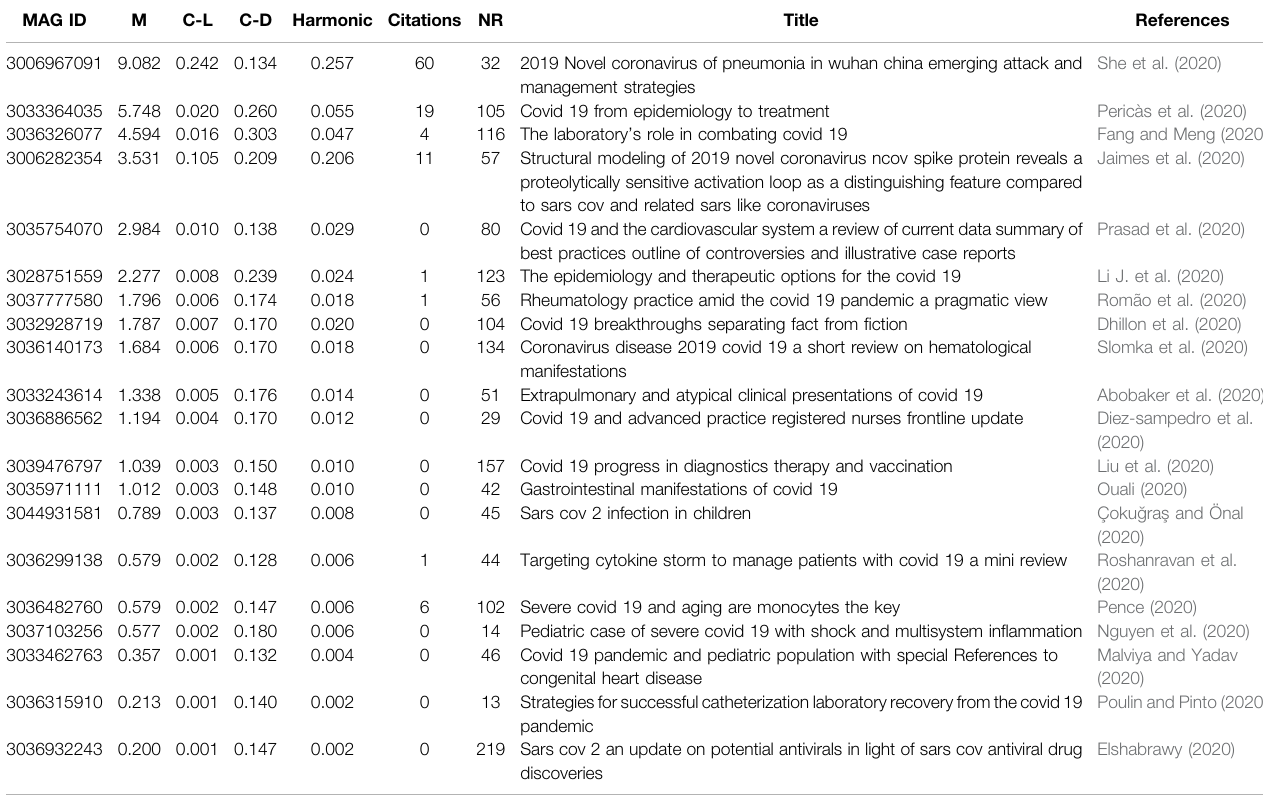
TABLE5| SomeofthearticleswiththestrongesttransformativepotentialsintermsofMformodularitychange.C-Lisforclusterlinkage.C-Disforcentralitydivergence.The Harmonic column shows the harmonic mean of M, C-L, and C-D. The NR column is the number of references cited by the corresponding article. MAG ID M